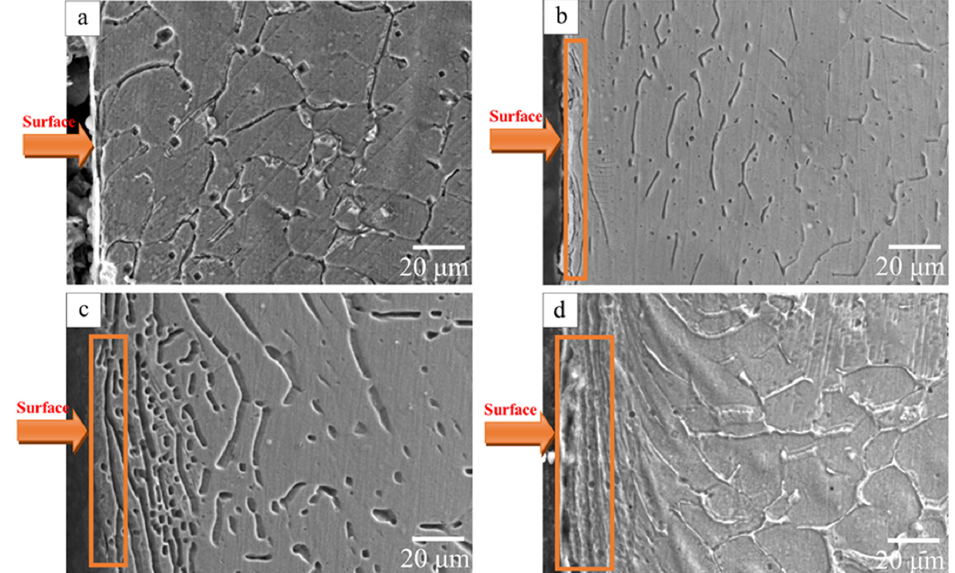
Figure 5. SEM images of the microstructure of cross sections of the welding zone of the 316L stainless steel samples after different laser shock peening: ( a ) matrix, ( b ) peening once, ( c ) peening twice, and ( d ) peening three times.